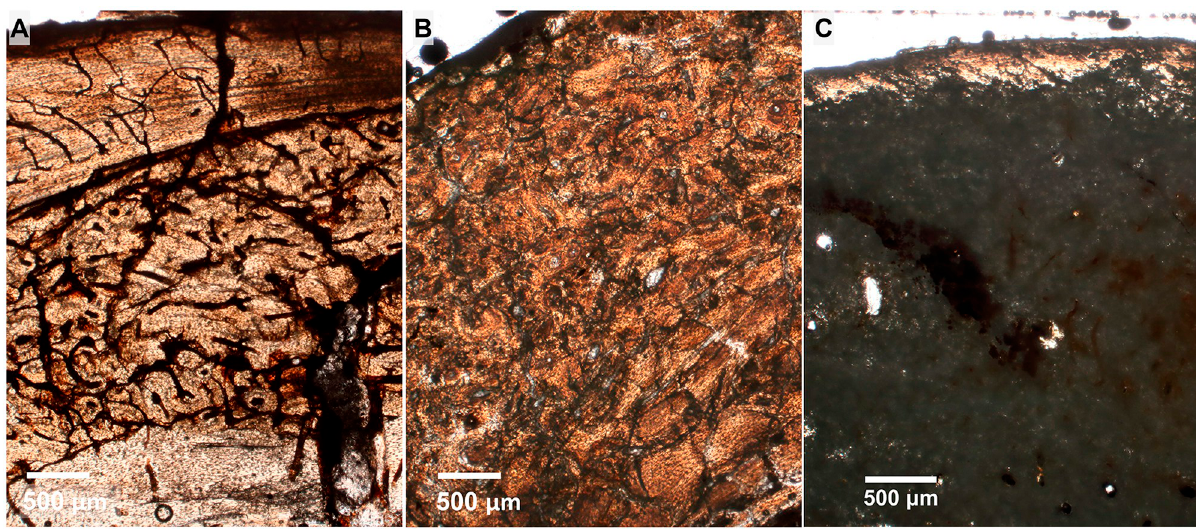
Fig 2. Degree of preservation in specimens of Caraguatypotherium munozi following the methodology used by Hollund et al. [69]. (A) State 1, well preserved (GEOUACH.HS.HD.1); (B) State 2, intermediate preservation (GEOUACH.HS.FD.1); (C) State 3, poor preservation (GEOUACH.HS.FI.1).